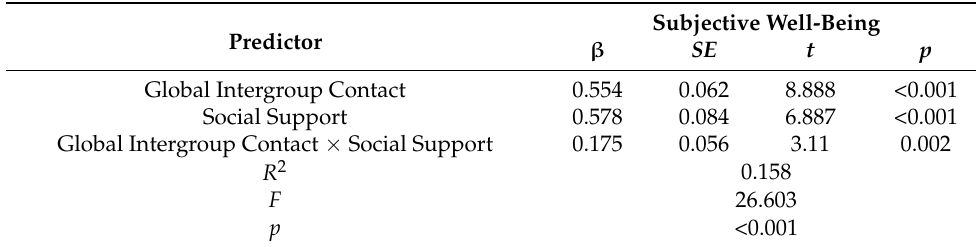
Table 5. Analysis of the moderating effect of perceived social support on intergroup contact and subjective well-being.